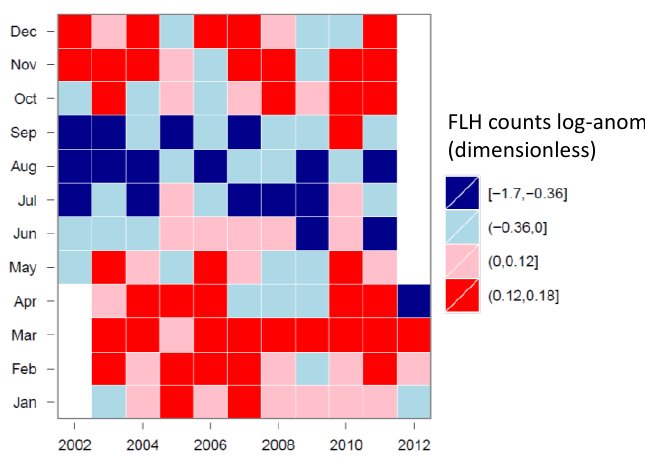
Figure 8. Tile-plot of FLH counts for the GBRW cluster